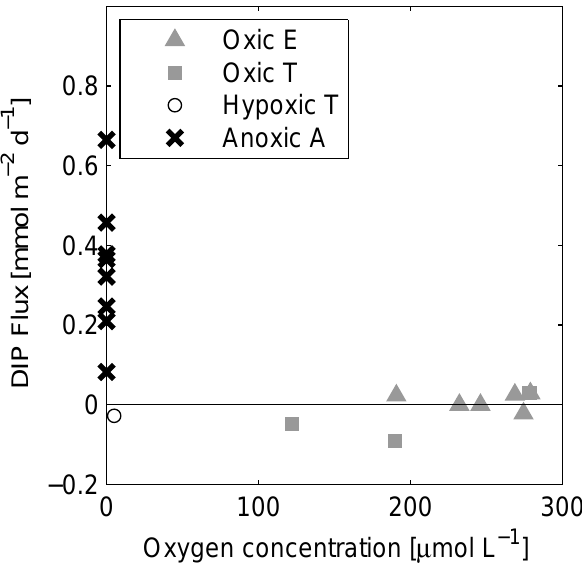
Fig. 8. DIP flux versus bottom water oxygen concentration; the latter was measured just before the start of the incubation inside the chambers. Fluxes are presented as mean values for each lander deployment.